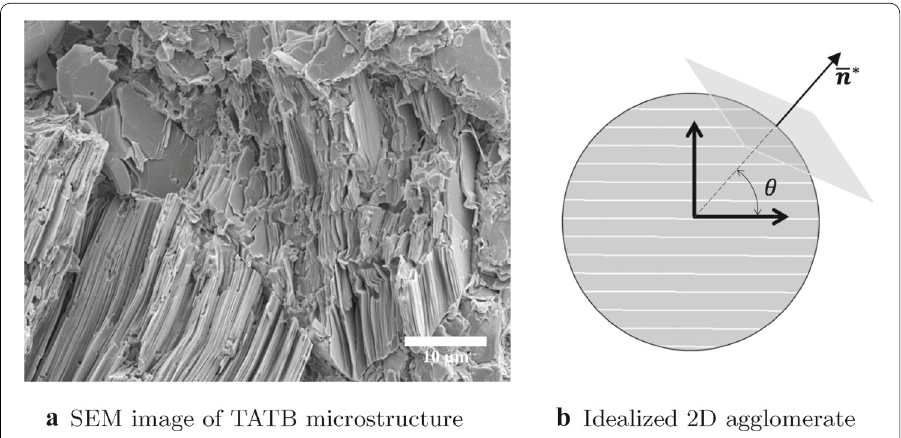
Fig. 4 Inter-granular contact between agglomerate grains: a SEM image of TATB microstructure showing interface between two agglomerate grains (from [6]), and b Idealized 2D agglomerate spherical grain comprised of perfectly aligned and bonded TATB crystal platelets. Slip-plane at n ∗ is described relative to the local grain axes aligned with crystals’ basal plane normal by angle